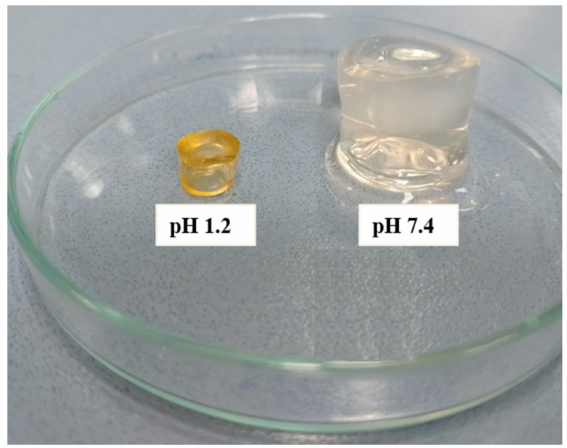
Figure 9. pH-responsive character of